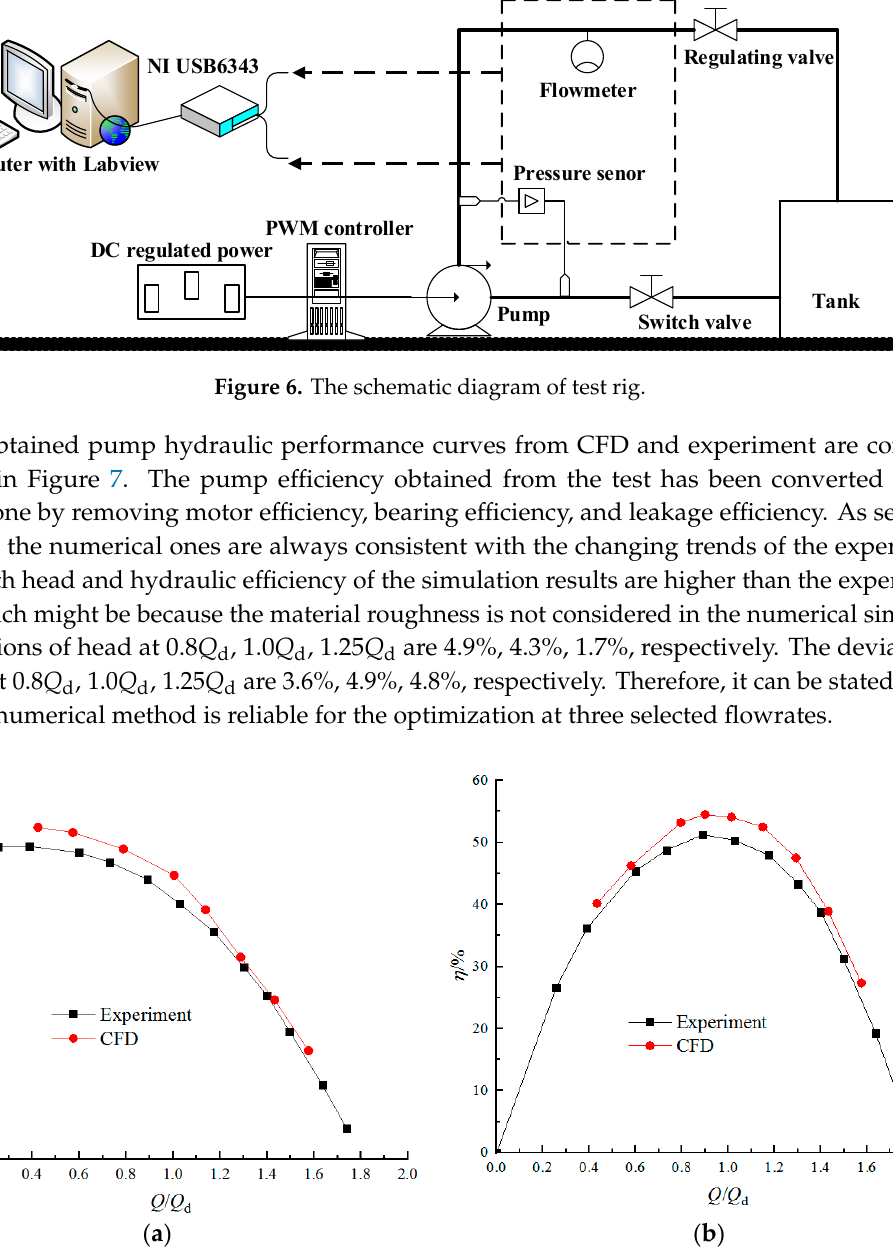
Figure 7. Comparison of pump performance between numerical and experimental results: ( a ) Head; ( b ) Efficiency.